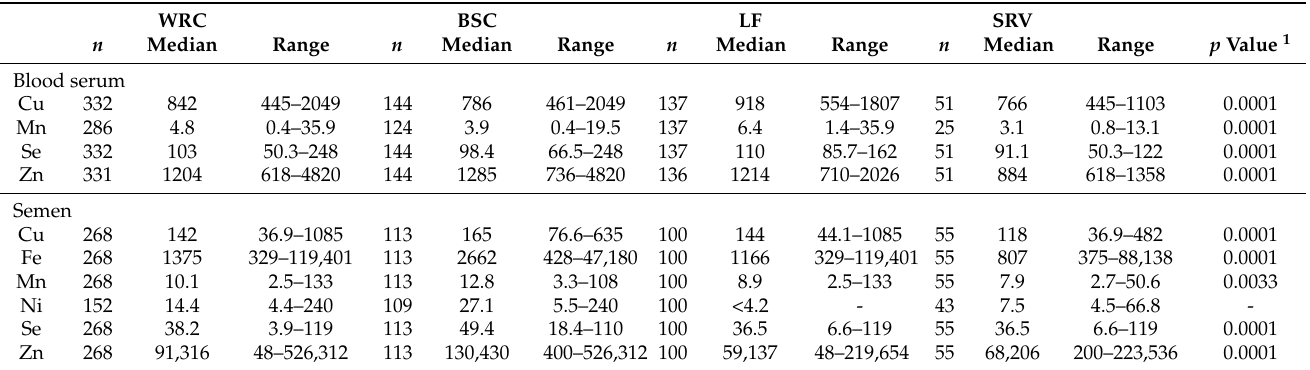
Table 2. Concentration of Group III—essential trace elements ( µ g /L) in blood serum and semen samples of the whole cohort (WRC) and three areas (BSC, LF, SRV), reported as median values and